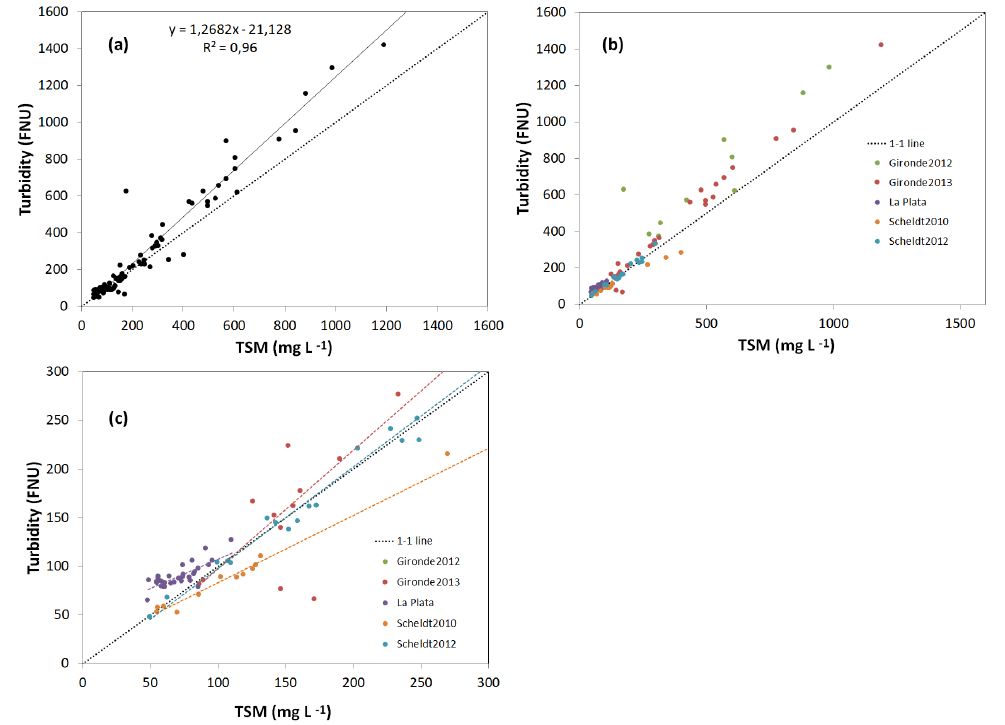
Figure 10. Intercomparison TSM and turbidity (a) for all sites, (b) different sites in different colors and (c) zooming in on lower concentra- tions of up to 300mgL − 1